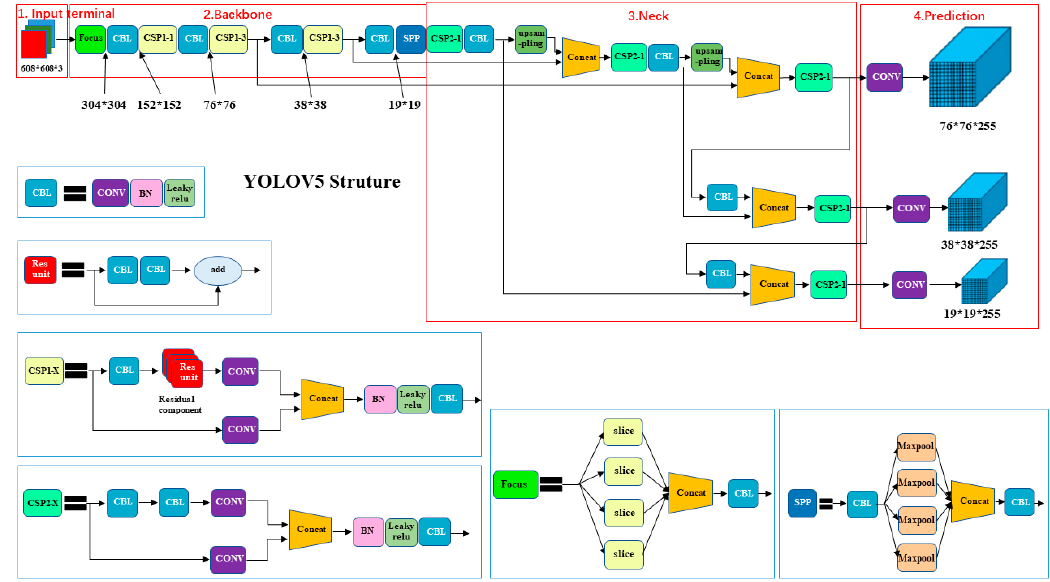
Figure 2. YOLOv5 frame diagram.